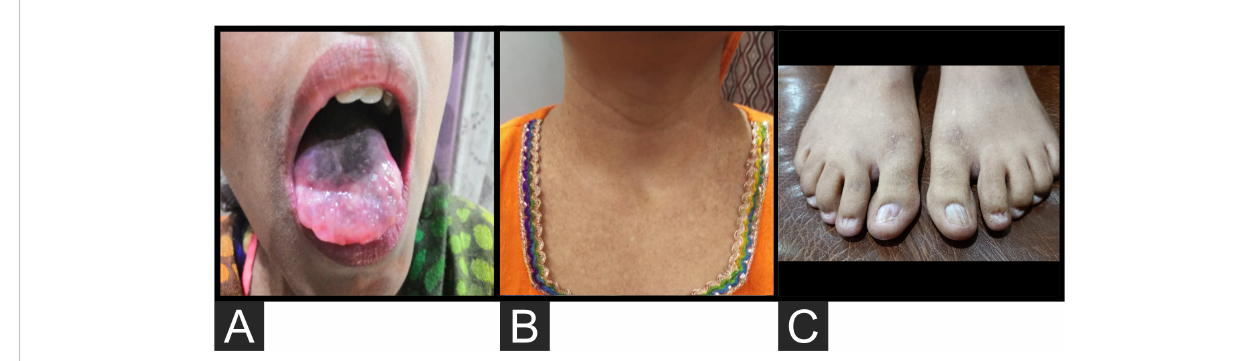
FIGURE 2 (A) Oral lesions. (B) Hyperpigmentation over the upper chest. (C) Dystrophic